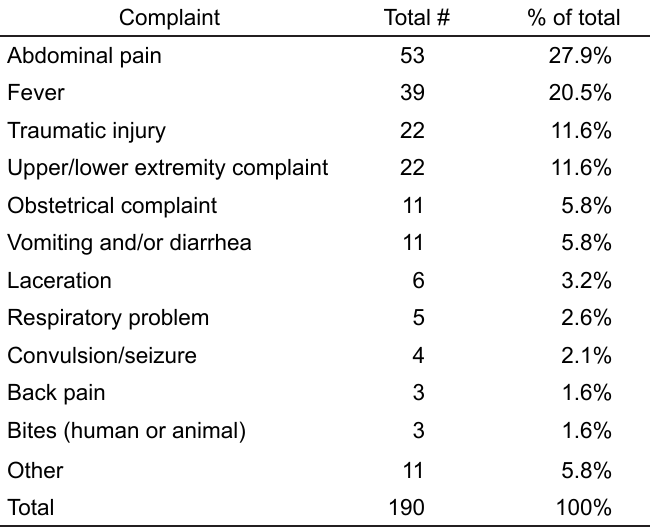
Table 2. Chief complaint by age, 6-18yrs.